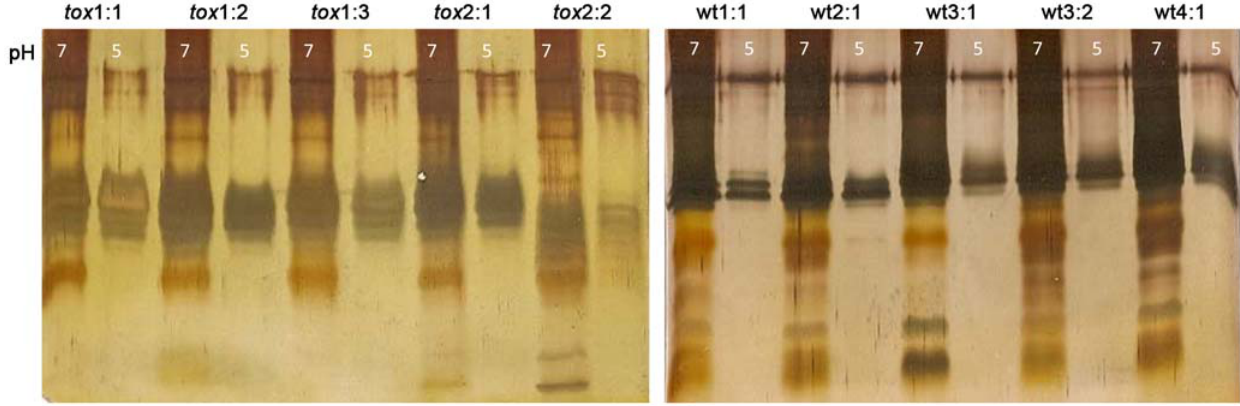
Figure 2. LPS profiles of HPAG1 isolates after a one-year colonization in germ-free wildtype and tox 176 mice. Silver staining of LPS from HPAG1 single-colony re-isolates after a one year-colonization of germ-free tox 176 (tox) and non-transgenic wildtype (wt) mice grown in vitro at pH 7 and pH 5. The analyses revealed that LPS from isolates grown at pH 7 displayed significantly higher levels of LPS expression than the isolates grown at pH 5, which demonstrated high-and low-molecular weight structures that were only weakly expressed or completely absent. doi:10.1371/journal.pone.0005885.g002 PLoS ONE |